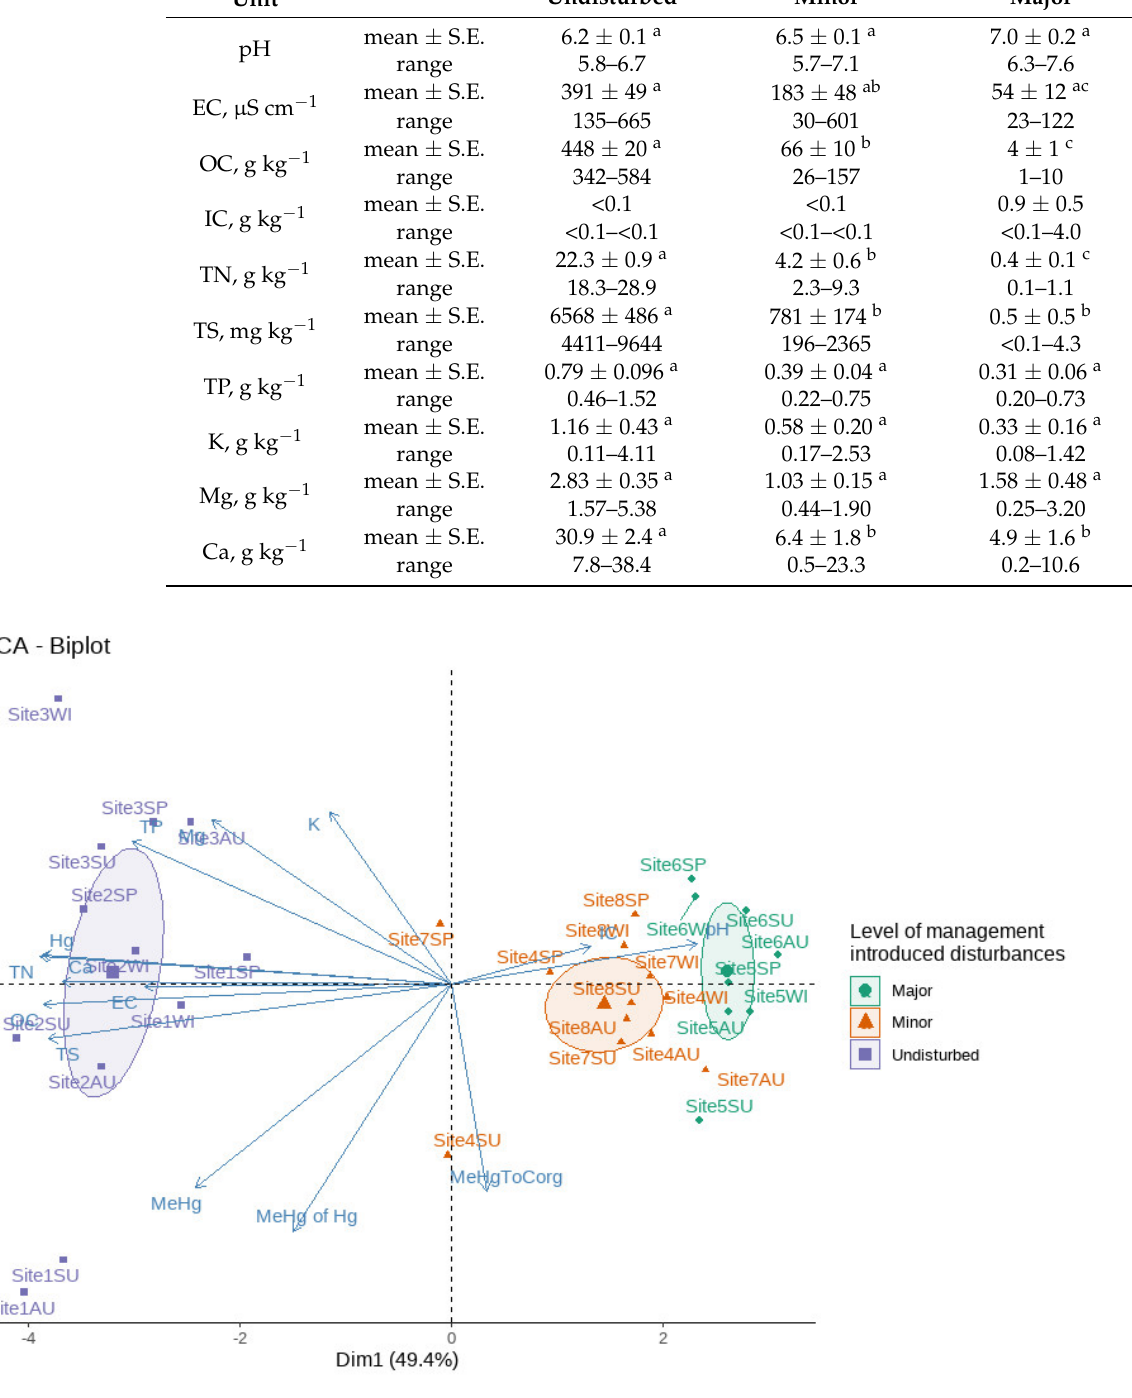
Figure 3. Physicochemical characteristics of the sampling sites. The ordination biplot of the PCA results shows that the sites are grouped by the differences in their physicochemical parameters. The THg concentration of the sediment samples was positively correlated with the OC concentration (r = 0.88), TN concentration (r = 0.93), TS concentration (r = 0.88), TP concentration (r = 0.80), Mg concentration (r = 0.57), Ca concentration (r = 0.88), and EC (r = 0.72). The MeHg concentration of the sediment samples was positively correlated with the OC concentration (r = 0.62, p < 0.001), TS concentration (r = 0.69, p < 0.001), and Ca concentration (r = 0.53, p = 0.002) (Figure S1). %MeHg was either not correlated or only weakly correlated (r < |0.50|) with the general physicochemical characteristics of the sed- iments. Some physicochemical parameters also differed significantly between the undis- turbed and disturbed sites, with the undisturbed sites exhibiting higher concentrations of OC, TN, TS, and Ca compared to disturbed sites (Table 2). The PLS analyses that at- tempted to explain the spatial variation of annual mean THg concentration in sediments (Table S1) resulted in a strong model, with one significant component exhibiting excellent goodness of fit (R 2 = 0.95) and goodness of prediction (Q 2 = 0.87; full cross-validation). The variables that best explained the variation in THg concentrations (VIP > 1) were the TN, TS, and Ca concentrations in sediments as well as the proportion of pine-dominated forest compared to the total forested area. However, sites with a higher proportion of pine-dom- inated forest from the total forest area in each catchment were predominantly those with-